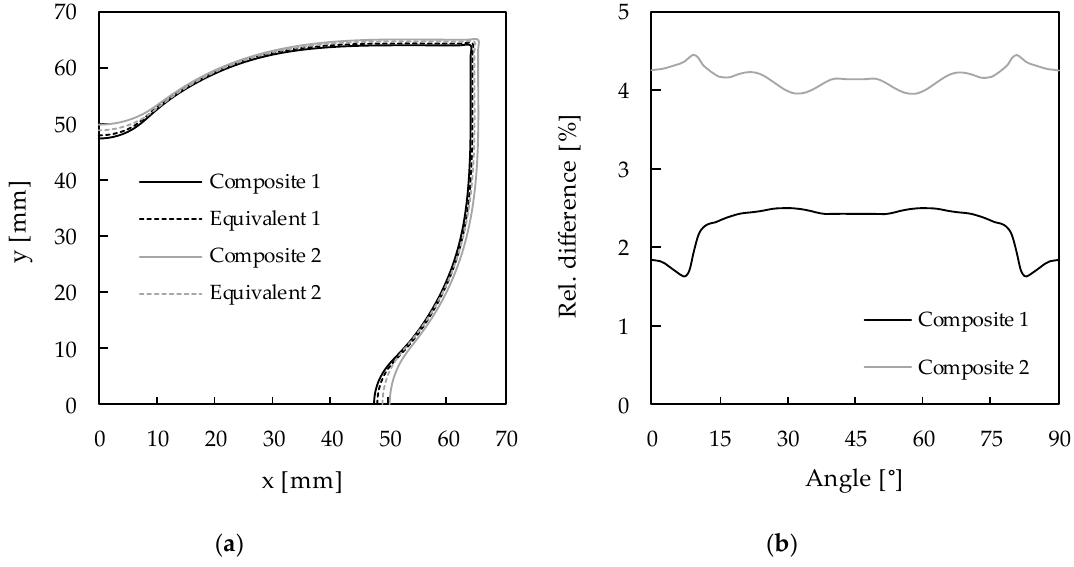
Figure 16. ( a ) Flange contour of the cases shown in Figures 14 and 15; ( b ) relative difference of flange draw-in between each composite and their equivalent material.